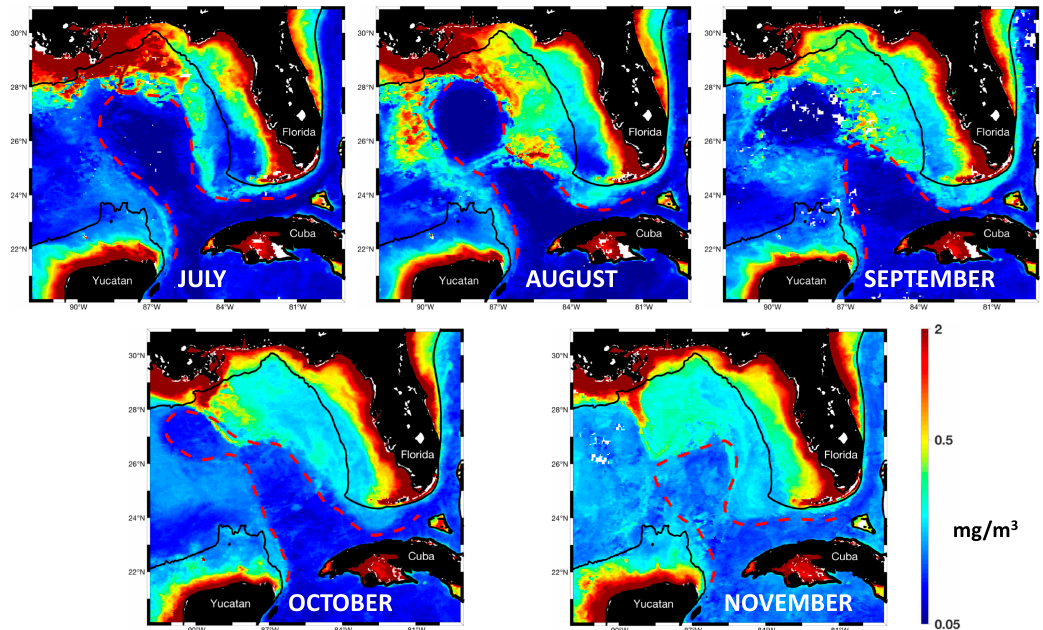
Figure 7. MODIS-Aqua chlorophyll-a monthly composite images from 2015 showing transport of water from the Mississippi Delta to the Florida Keys. Solid black line represents the 100 m isobath. Dashed red line represents the contour of the Loop Current estimated from the monthly average of altimetry derived MADT data for each month.